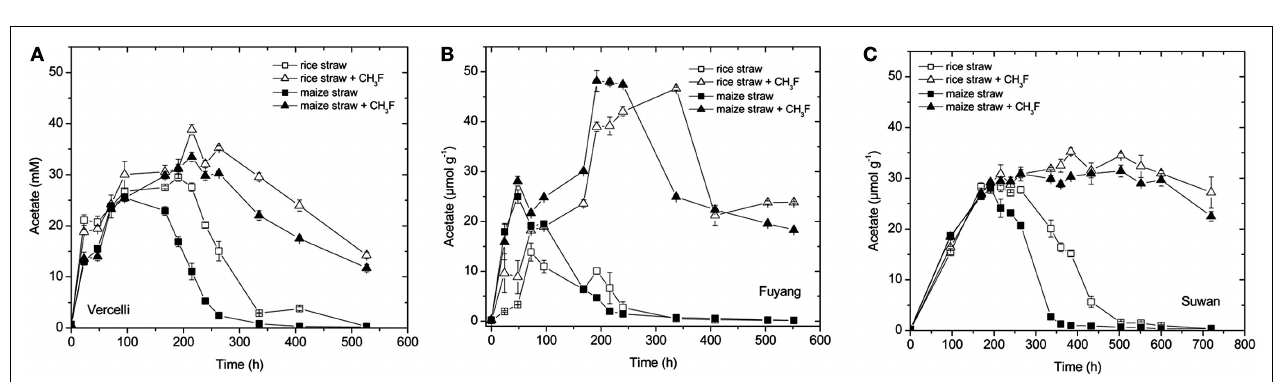
FIGURE 1 |Accumulation of CH 4 in soil from (A)Vercelli, (B) Fuyang, and (C) Suwan, amended with either rice straw or maize straw and incubated